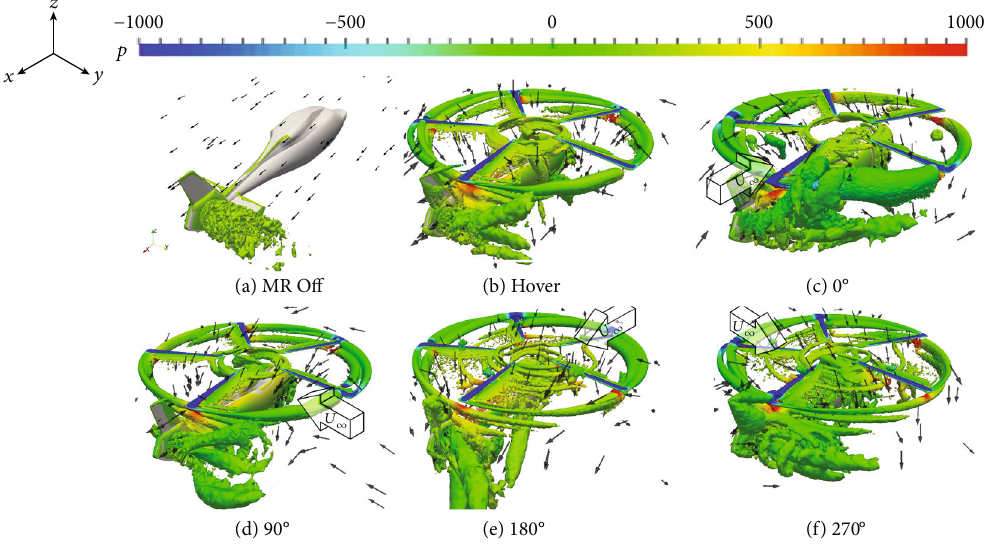
Figure 9: Q iso-surface colored with